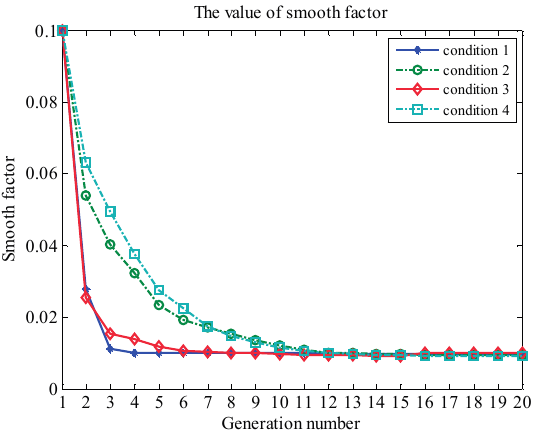
Figure 8. The value of the smoothing factor under different conditions.